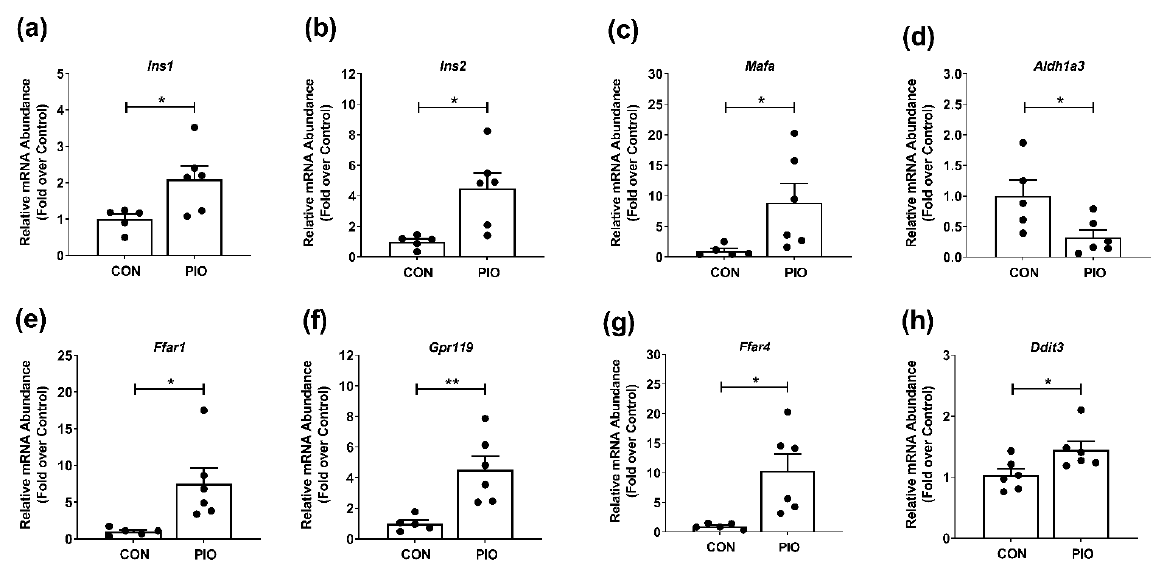
Figure 7. Islet gene expression reflects improvements in markers of the differentiated state in db/db mice receiving pioglitazone. Gene expression of ( a ) Ins1 , ( b ) Ins2 , ( c ) Mafa , ( d ) Aldh1a3 , ( e ) Ffar1 , ( f ) Gpr119 , ( g ) Ffar4 , and ( h ) Ddit3 in islets isolated from db/db mice fed either a CON or PIO-supplemented diet for 28 d. n = 6 per group. Data are represented as the means ± SEM. * p < 0.05, ** p < 0.01.